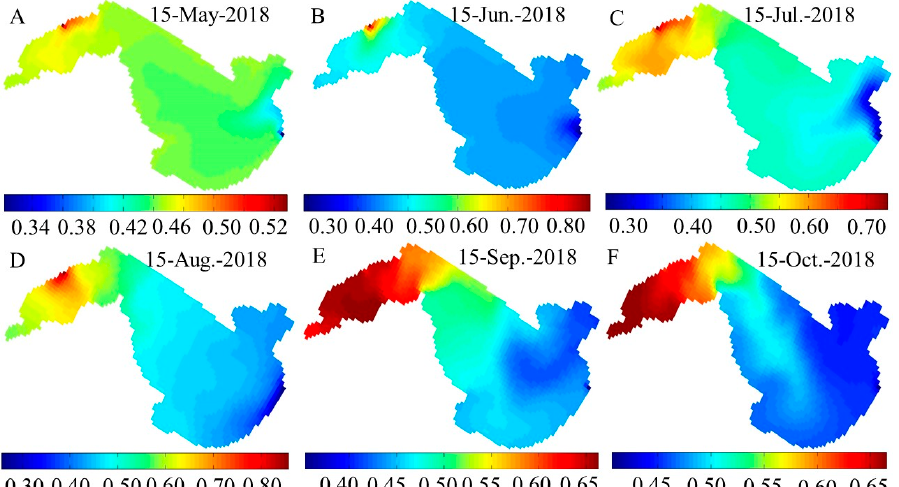
Figure 6. The tendency of salinity in Chagan Lake from 2008 to 2018. Each boxplot illustrates the median and inter-quartile range and the whiskers indicate minimum and maximum values. The blue solid line indicates the fitting line of salinity. The black points indicate the outliers.